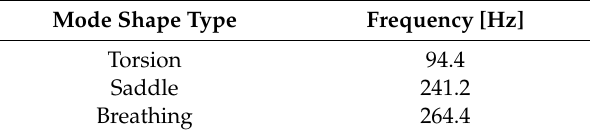
Table 4. IET frequency test results of the Poisson plate.